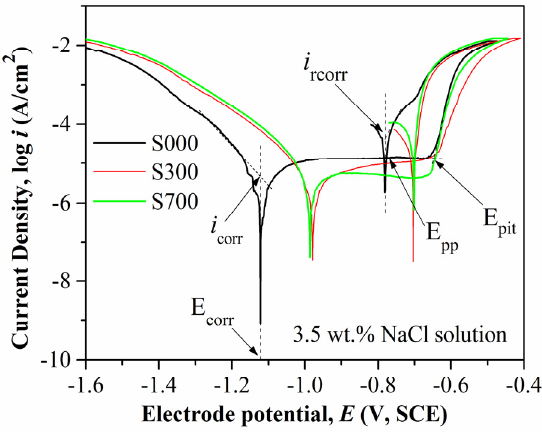
Figure 4. Cyclic anodic polarization curves of base metal (S000) and FSP samples (S300 and S700).